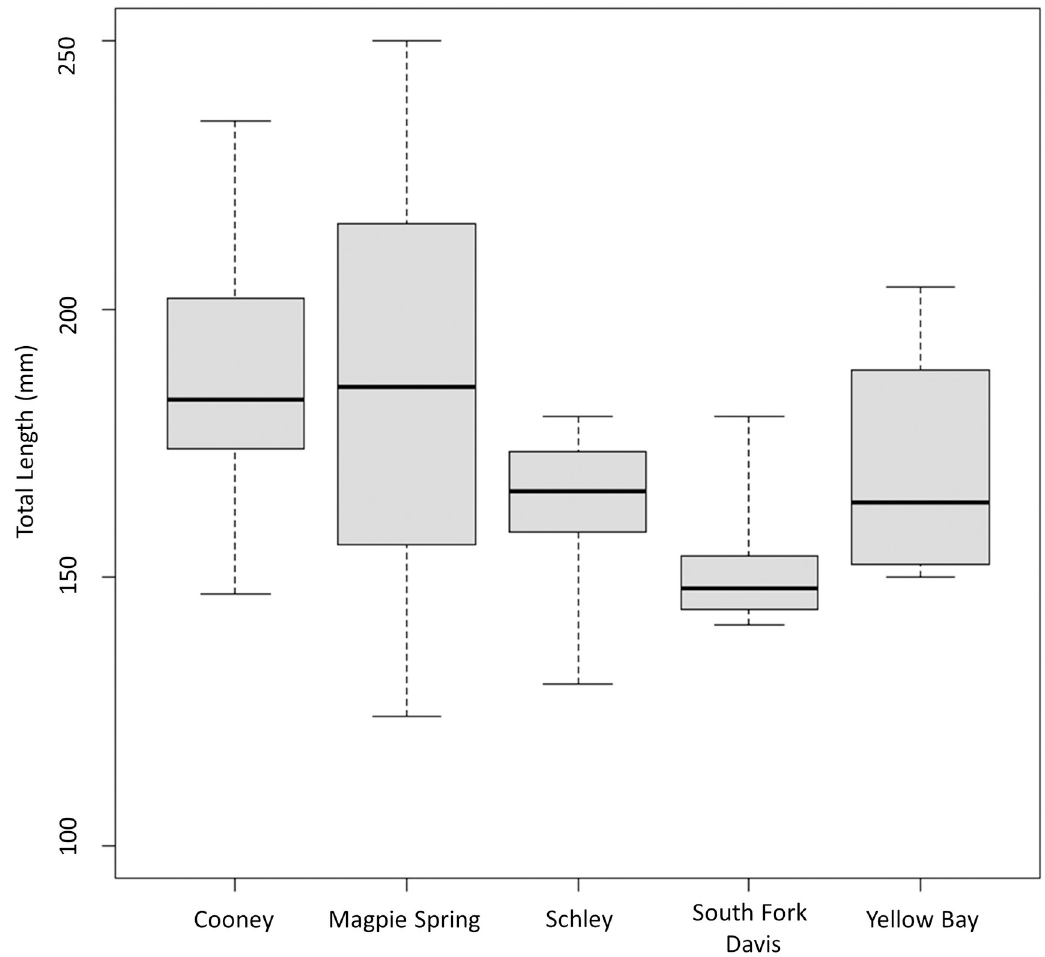
Fig 4. Box plot showing the total length (mm) of mature female Westslope Cutthroat Trout from wild resident populations in western Montana. Bold black lines are the median total length of mature females, boxes show the interquartile range, and whiskers are the data range. A Dunn’s post-hoc test found significant differences in the median size of maturing females between South Fork Davis Creek and both Cooney and Magpie Spring Creeks,